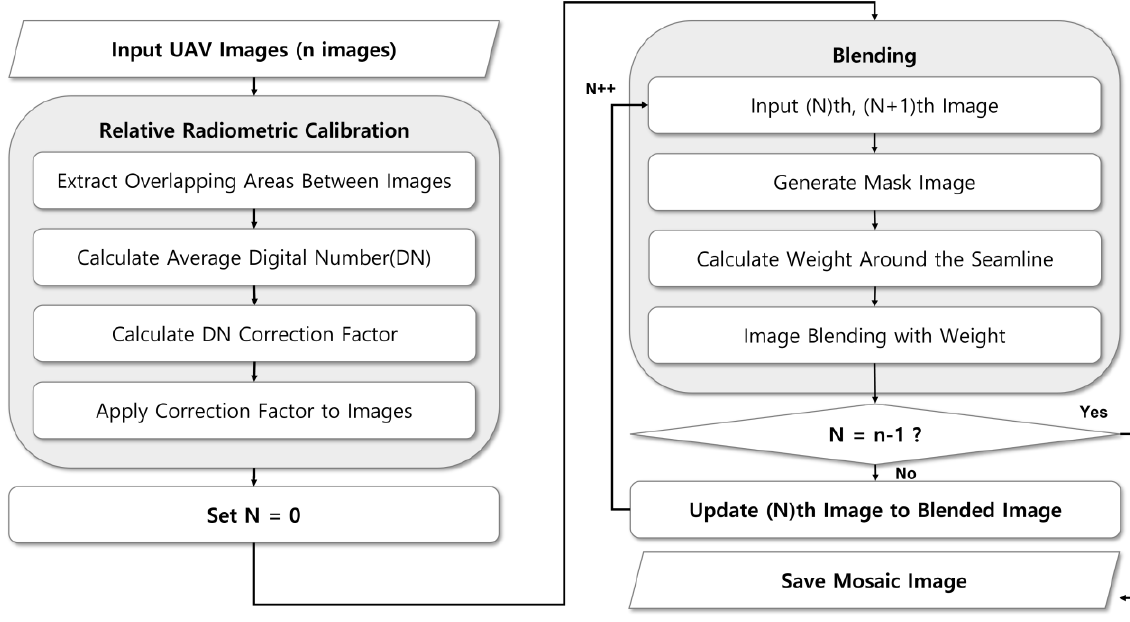
Figure 2. Process for generating mosaic image of proposed method